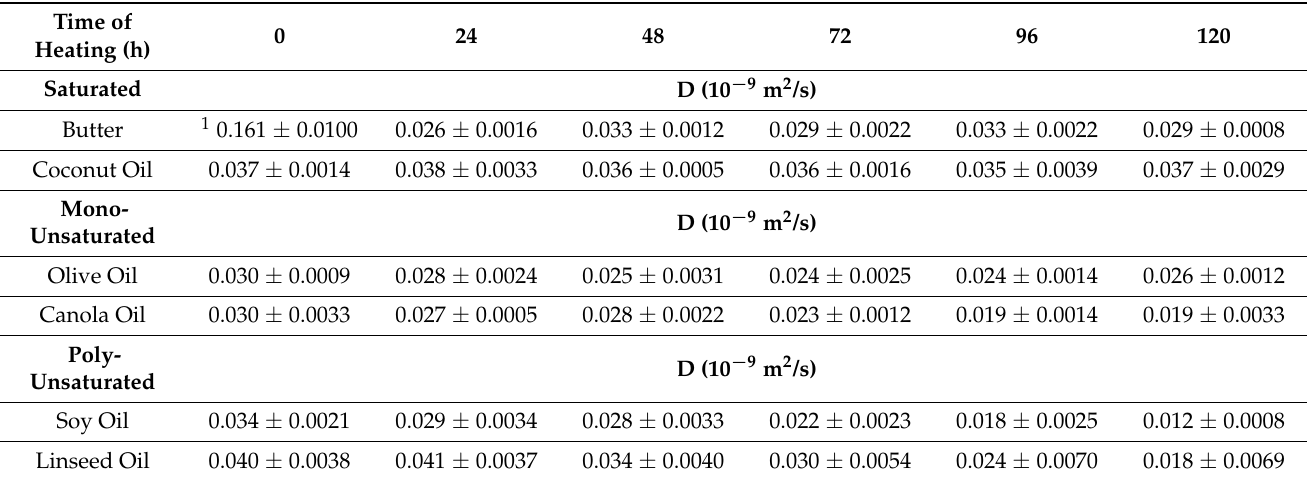
Table 2. Self-diffusion (D) values of saturated, monounsaturated, and polyunsaturated edible oils during thermal oxidation stimulation conditions at 80 ◦ C (average + SD is